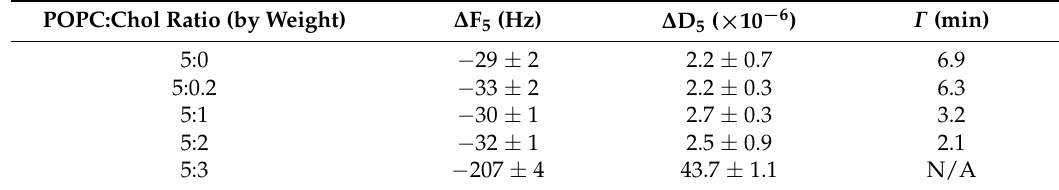
Figure 2. Protein binding on lipid bilayers with different levels of cholesterol content. The lipid bilayers were formed on top of the sensor surface via liposome fusion. This is represented as zero value at the beginning of each curve. Cyt2Aa2 of 25 µ g/mL (1 µ M) was filled into QCM-D chamber; then, the flow was paused in order to evaluate the lipid binding of Cyt2Aa2 protein for 2 h. After that, the systems were rinsed by PBS, as indicated by the arrows. The solid and dash arrows indicate points of protein injection and buffer rinsing, respectively. ( A ) The quantitative lipid binding of Cyt2Aa2 protein is observed in decreasing of ∆ F. ( B ) The viscoelastic property of the layer is coincidently determined with increasing of ∆ D. ( C , D ) Zoom-in of ∆ F plot and ∆ D plot for the first 60 min, respectively. These plots show the evolution of protein–lipid binding at the early time of incubation before reaching the saturated state. Table 2. Summary of the final change in frequency ( ∆ F), dissipation ( ∆ D), and time constant of decay ( Г ) at saturated state of Cyt2Aa2 protein binding on lipid bilayers with different levels of cholesterol content.